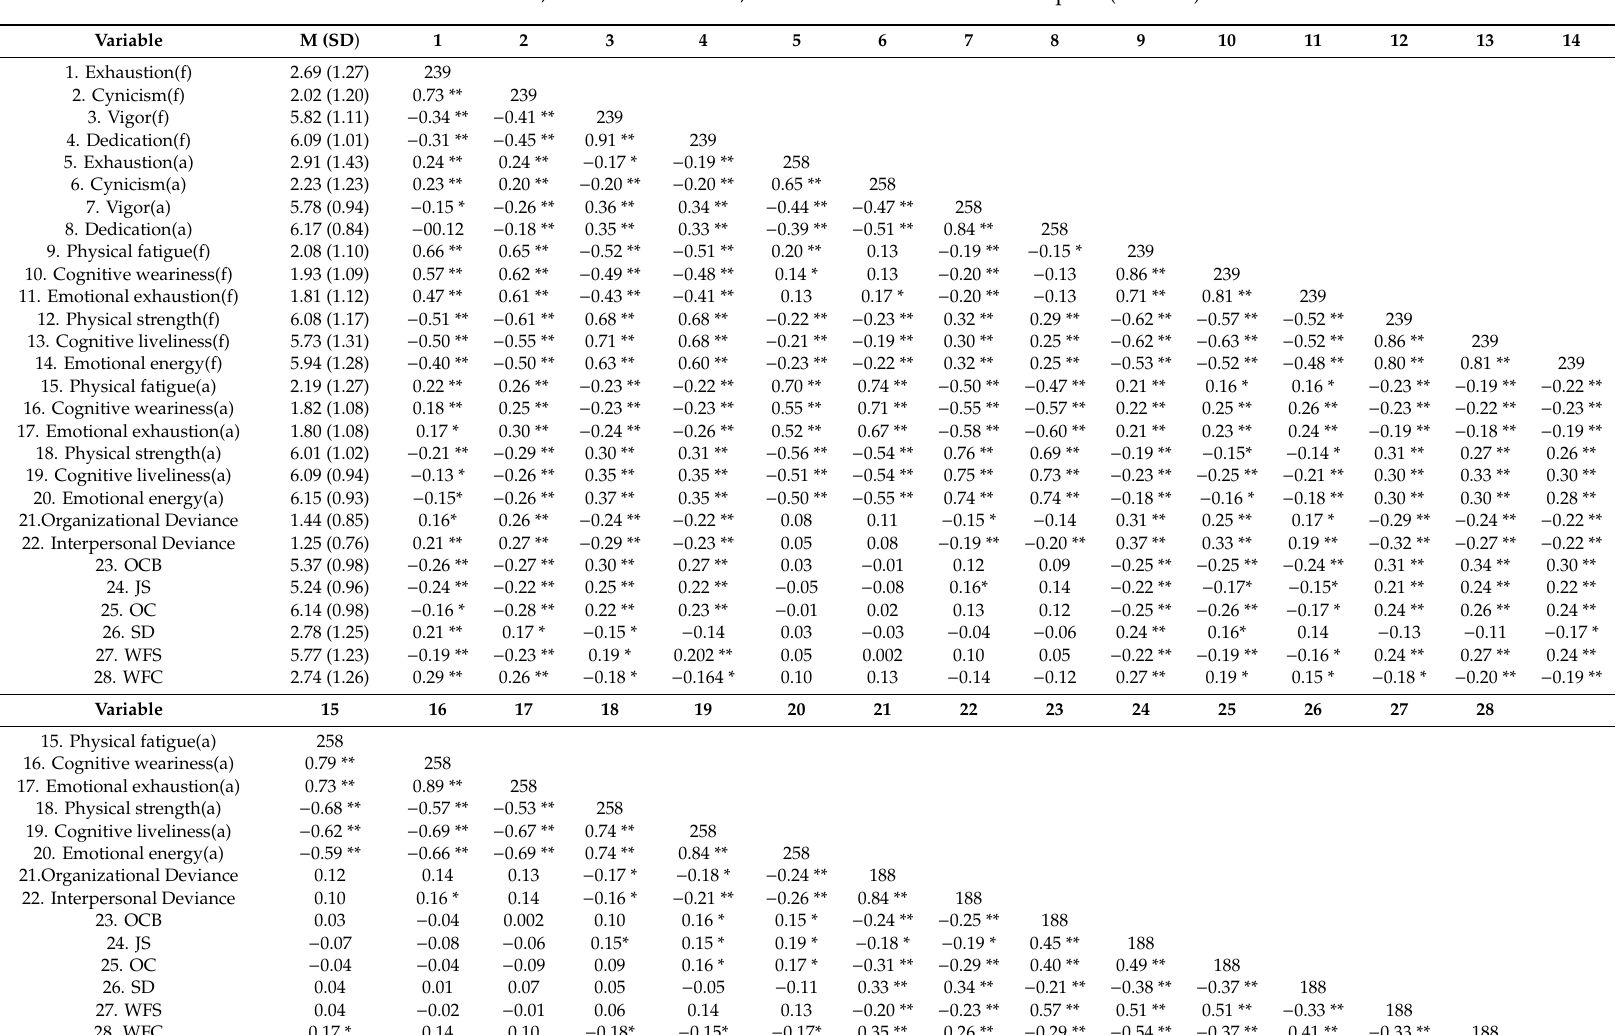
Table 3. Mean, standard deviation, and correlation matrix for Sample 2 ( N =